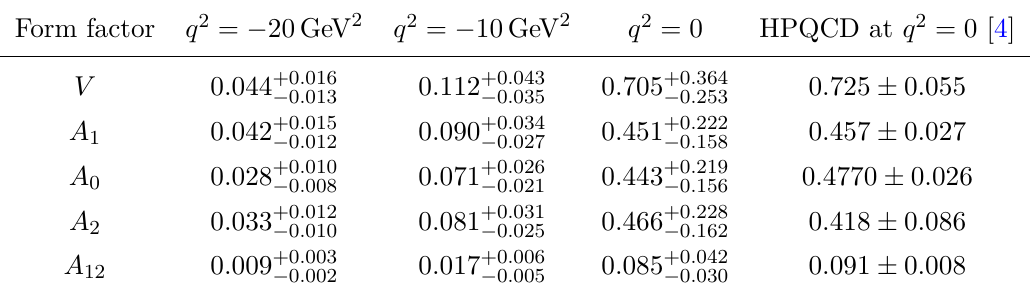
Table 3 . Numerical results for the B c → J/ψ form factors. The central values (asymmetric uncertainties) correspond to the medians of the distributions (the 68% confidence